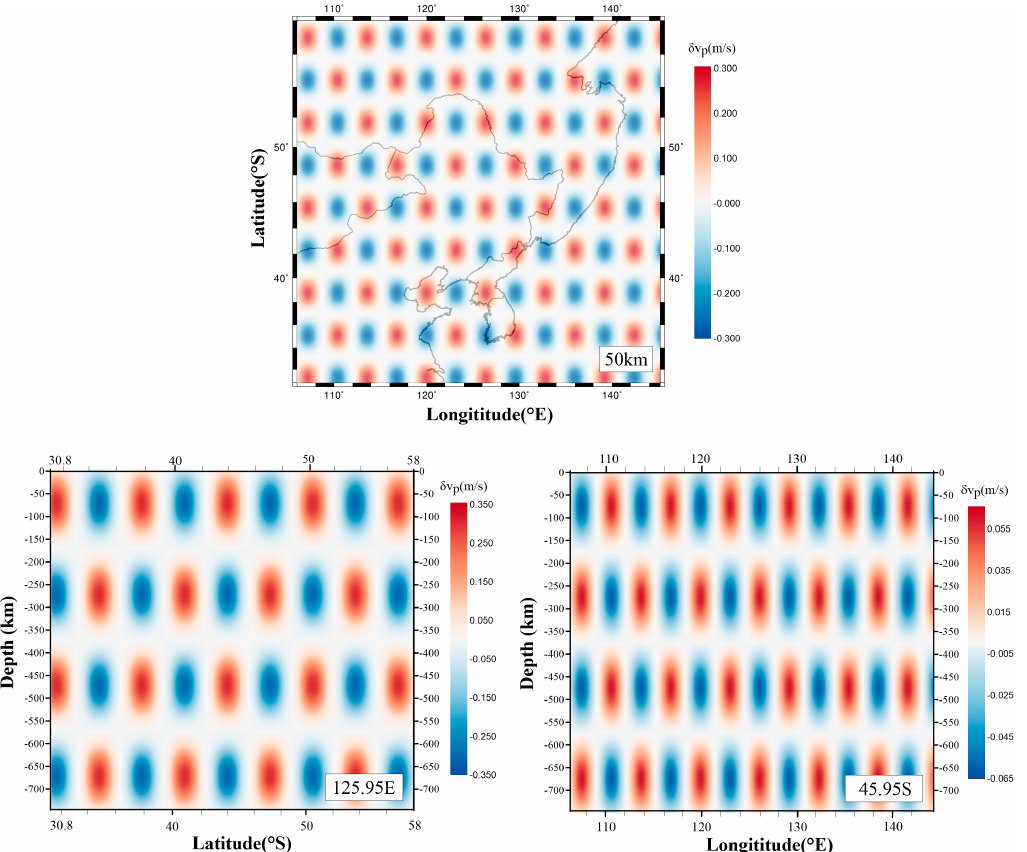
Figure 7. Initial model with a 0.8° × 0.8° × 50 km grid.